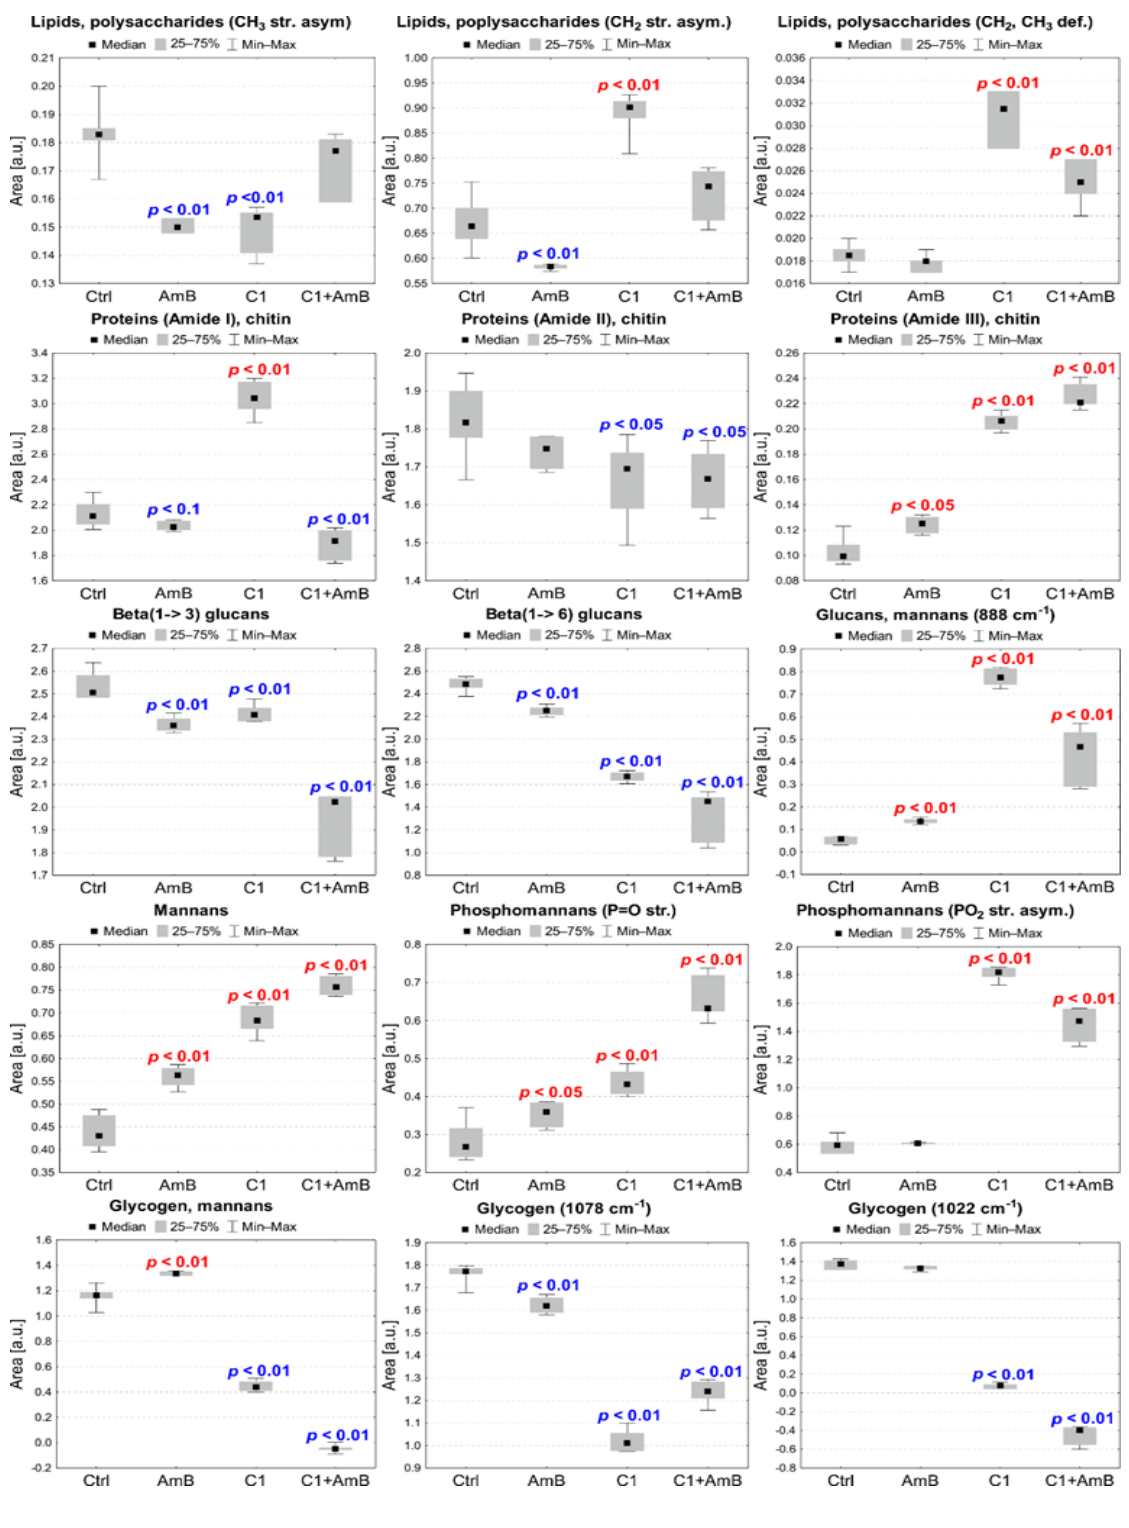
Figure 7. The median, minimal, and maximal values of intensities of selected absorption bands presenting differences between C. albicans exposed to AmB, C1, and C1 + AmB treatment and control (Ctrl) group. The p -values of Mann–Whitney U test for statistically significant changes compared with the control are placed on the charts (red—ncreases,